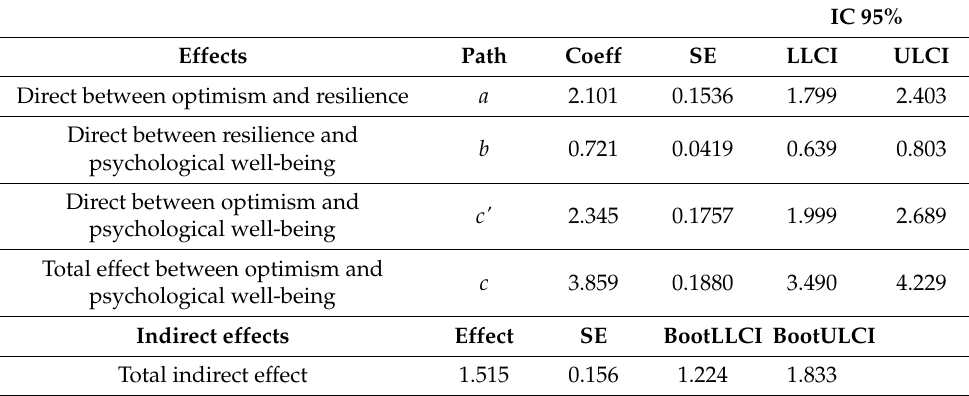
Table 4. Simple mediation analysis of optimism regarding the relationship between resilience and psychological well-being, controlling for economic and socio-demographic variables during confinement in